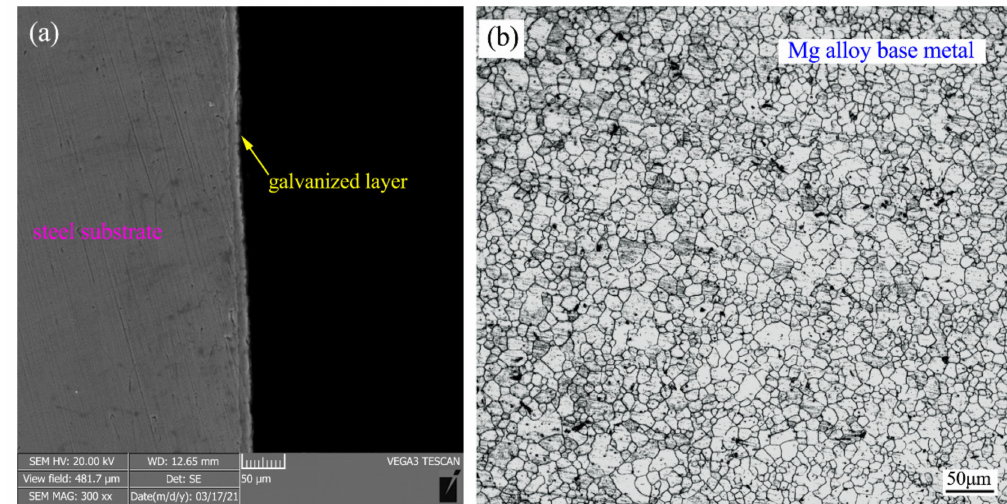
Figure 1. ( a ) Microstructure of galvanized steel and ( b ) Mg alloy base material.